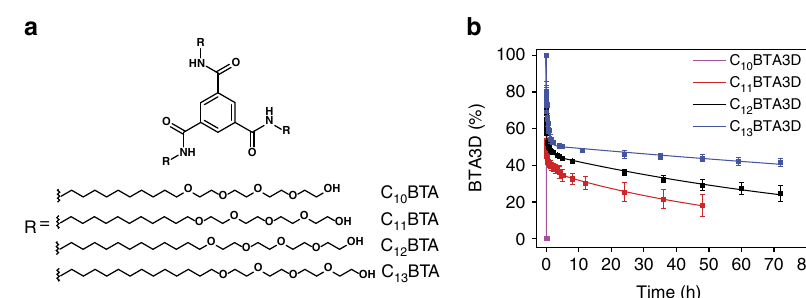
*Less than 8% of C 12 BTA3D was left after 5h at 55 (cid:2) C, hence calculation of these values was omitted.